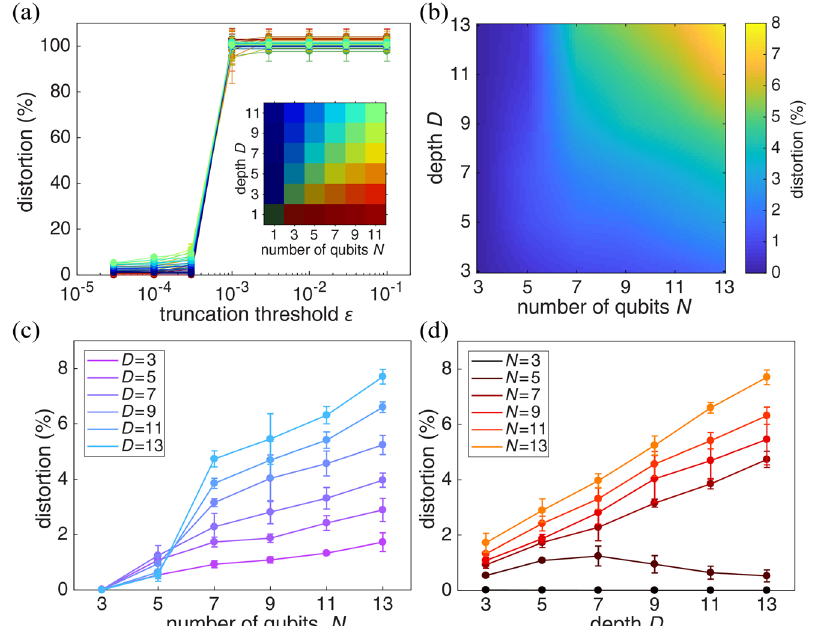
Fig. 4 Error benchmarking under depolarizing noise. a Distortion as a function of number of qubits N , circuit depth D , and ϵ . (Inset) The colormap for the curves, indicating their circuit size. b Distortion as a function of N and D with ϵ = 10 − 4 . c Horizontal line cut of b . d Vertical line cut of b . Depolarizing noise has p = 0.1%. The error bars are standard-deviation-calculated across a set of